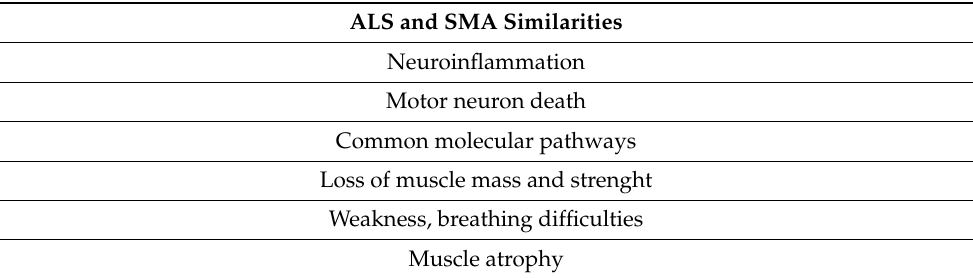
Table 2. Similarities between ALS and